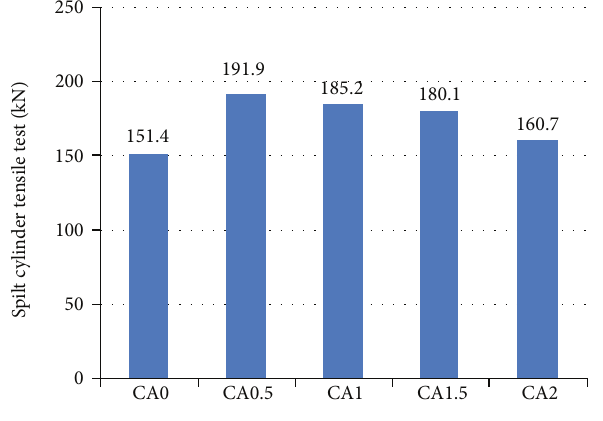
the sample with no additives, but by increasing the percent of polymer and micro-SiO 2 the split cylinder tensile